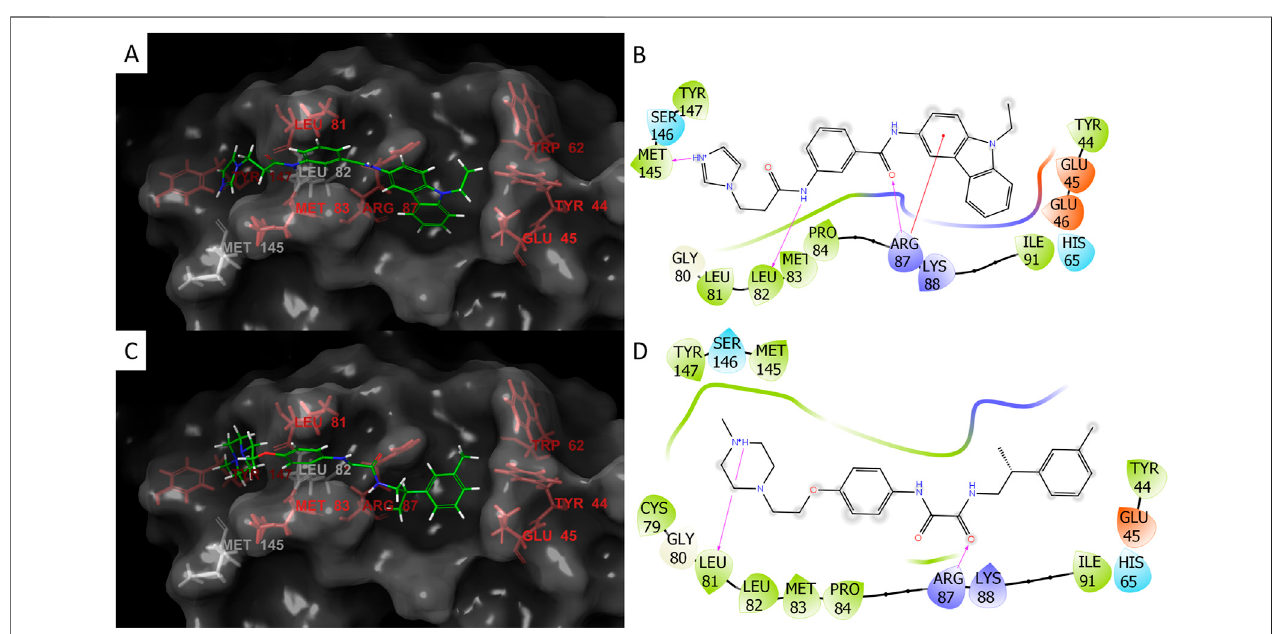
FIGURE2| DockingposesandinteractionsofthetwoinhibitorsZ786028994 (A,B) andZ1290281203 (C,D) .Forthe3Dimagesoftheposes:hotspots-red,non- hot spot residues- white, and ligand- green. For the 2D interaction plots: negative charge- red, positive charge- blue, hydrophobic residues- green, hydrogen bonds- purple arrows (the direction is donor to acceptor), and red line to the aromatic ring represents Pi-cation interaction. Both molecules span the length of the docking site and the small grooves in the protein provide partial protection from solvent (A,C) . Z786028994 has hydrogen bonds with ARG87, LEU82, and MET145 (B) and Z1290281203 has hydrogen bonds with two hot spots, ARG87 and LEU82 (D) .